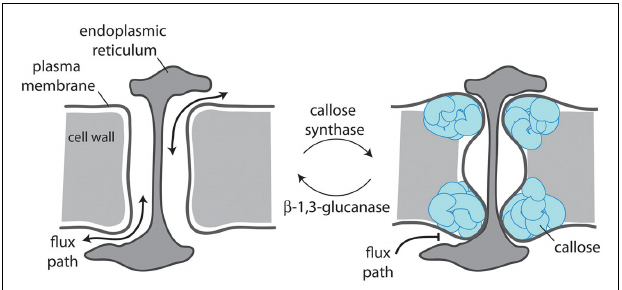
FIGURE 2 | Plasmodesmal aperture is regulated by callose deposition in the cell wall surrounding the neck of the pore. Plasmodesmata- located callose synthases and β -1,3-glucanases control callose turnover which dictates whether a plasmodesma is open (left) or closed (right) and whether movement can occur freely between cells (left) or is obstructed